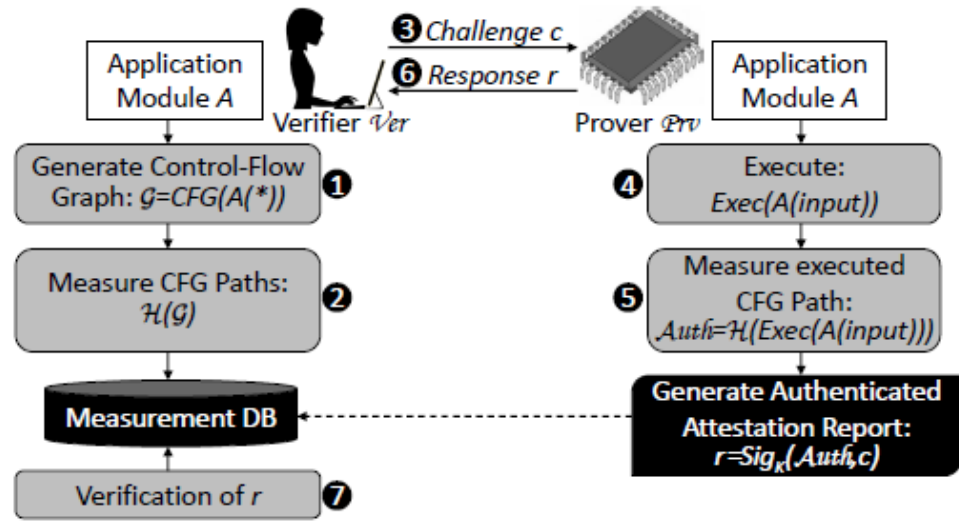
Figure 2. C-FLAT original system model ©Abera.